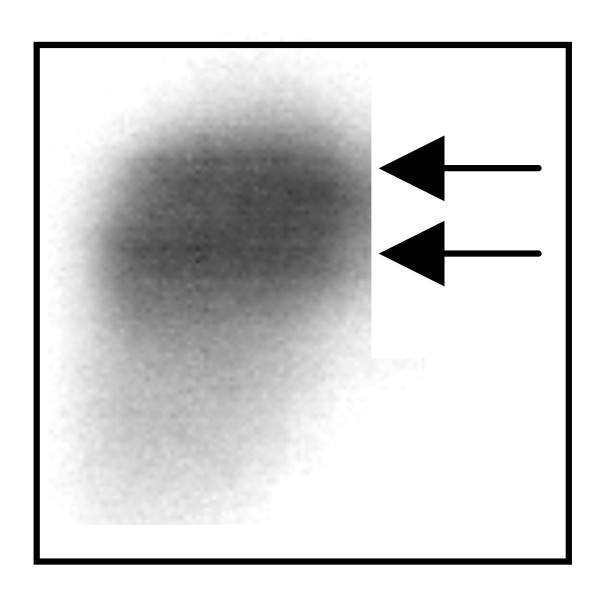
Northern blot analysis of GcvB from Y. pestis strain KIM6. Total cell RNA was isolated from strain KIM6 grown in HIB at 30°C to an O.D.600 of 0.7 and probed with a 32P-labeled GcvB specific DNA probe as described in Methods. Two gcvB transcripts of about 206 and 130 nucleotides identified are indicated with arrows. Their sizes were determined based on their mobilities relative to the mobility of the E. coli GcvB RNA and 5S rRNAs (not shown).